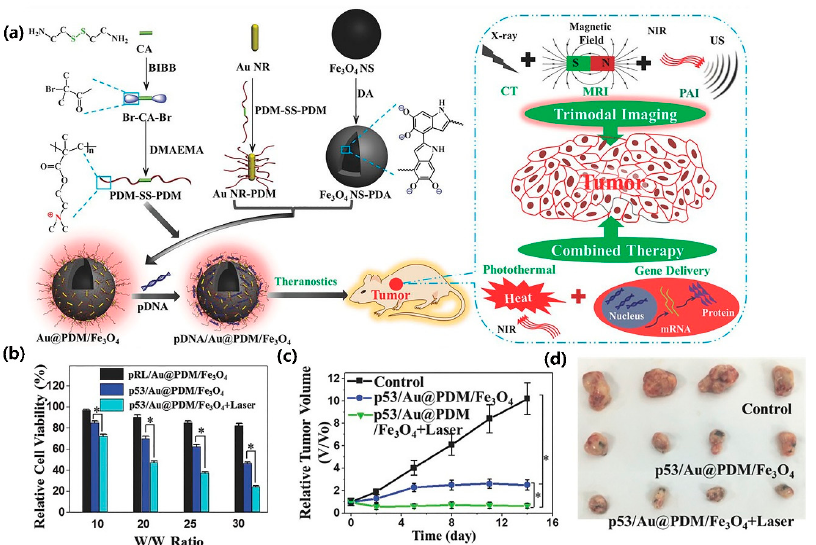
Figure 8. ( a ) Preparation of Au coated Fe 3 O 4 . ( b ) Cell viability of C6 cells after various treatments. ( c ) The C6 tumor growth curves of mice after various treatments, where the tumor volumes were normalized to their initial tumor sizes (mean ± SD, n = 4). ( d ) Photographs of ( c ). Reproduced from “Multifunctional pDNA-Conjugated Polycationic Au Nanorod-Coated Fe3O4 Hierarchical